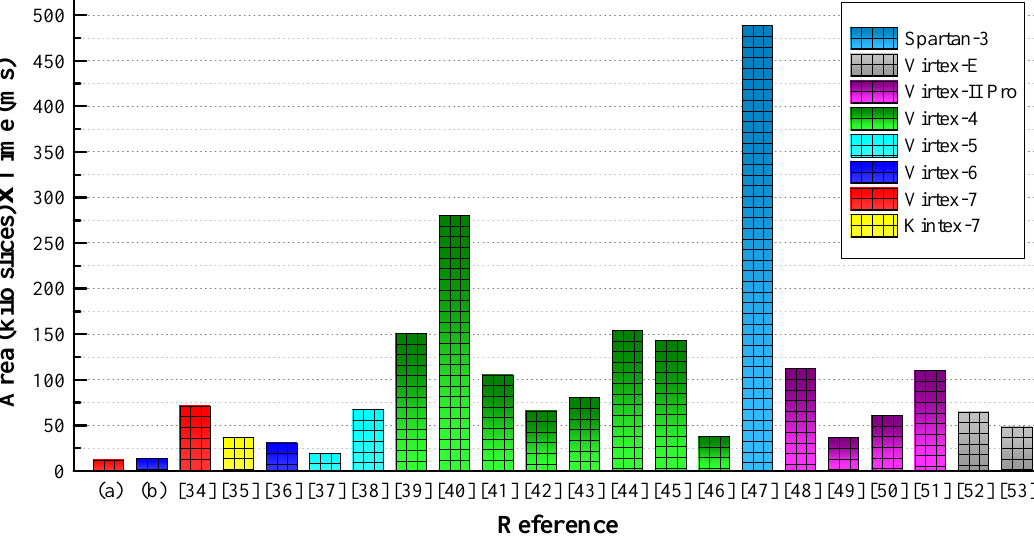
Figure 9. Performance comparison in terms of AT